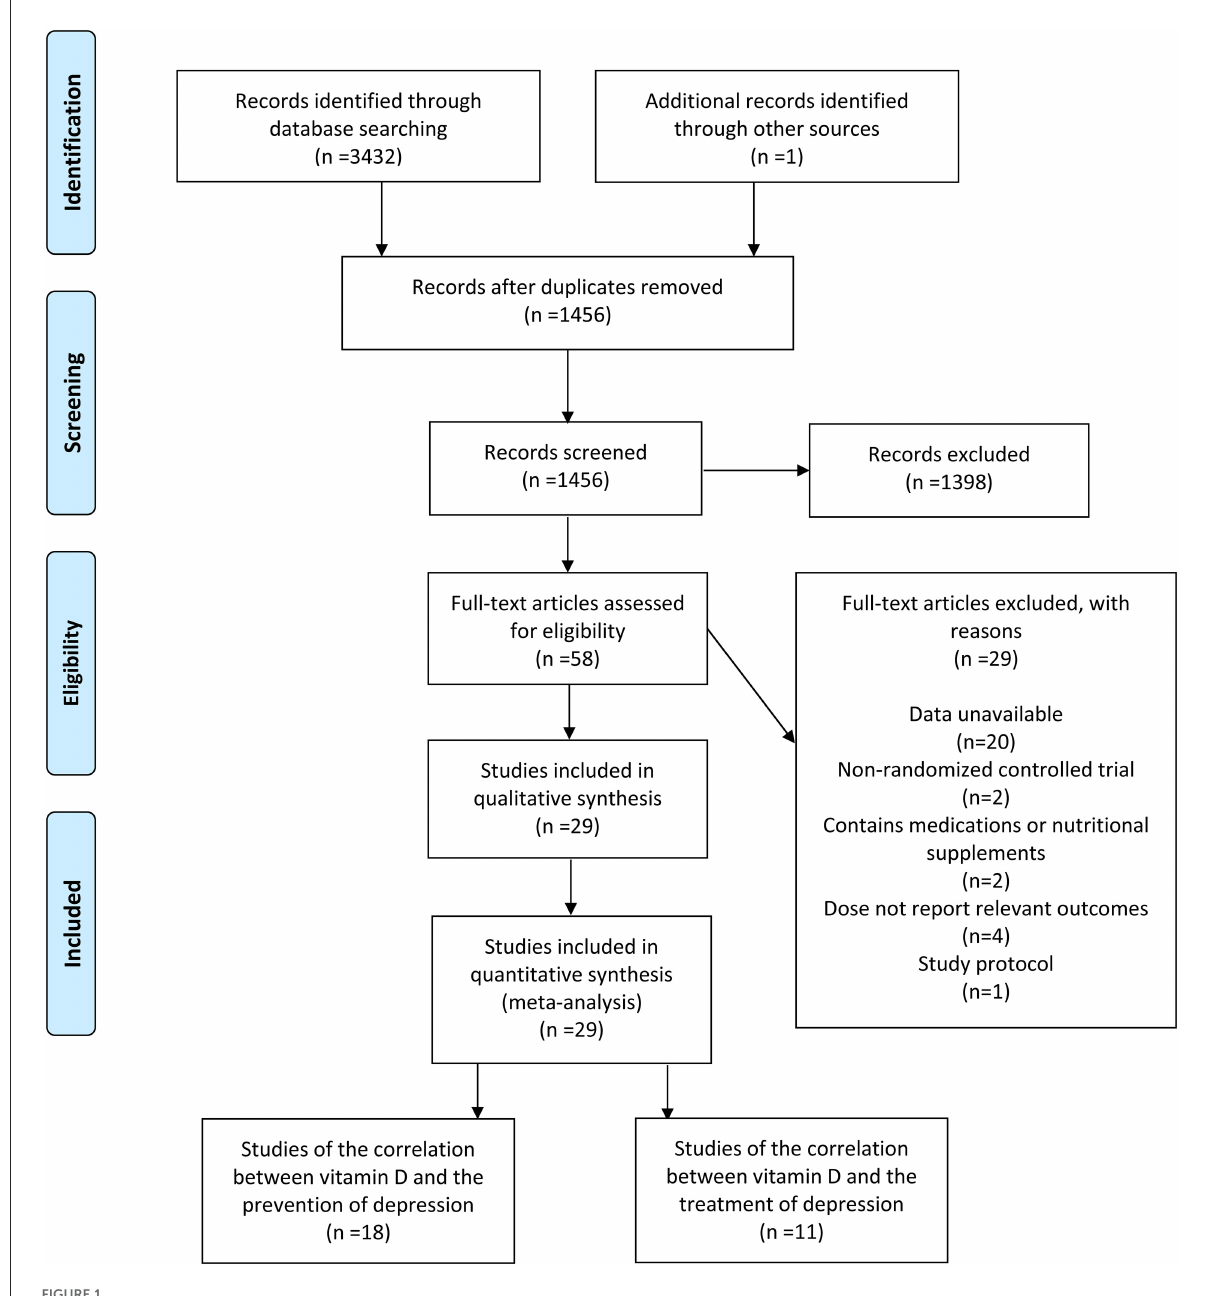
FIGURE1 Flow diagram describing inclusion and exclusion